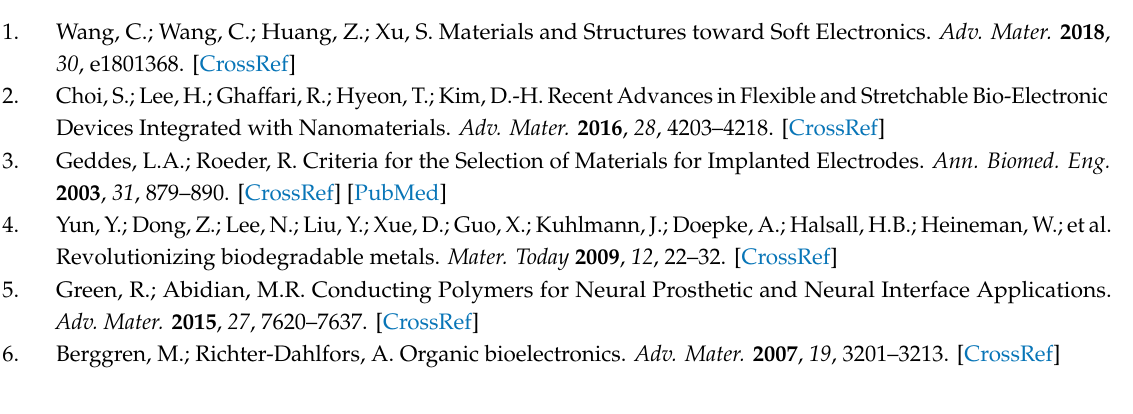
“Figure S1: Testing procedure to obtain the conductivity for bare and sheathed conducting fibers, Figure S2: PEDOT:PSS fibers spun using di ff erent gauge needles, Figure S3: PEDOT:PSS fibers spun using di ff erent weight % of the dope solution with the same gauge needle, Figure S4: Optical images showing the fibers and the cross-section SEM images, Figure S5: Testing the insulation e ffi cacy of the silk fibroin sheath, Figure S6: Response of the fully integration biosensor device to additions of the neurotransmitter